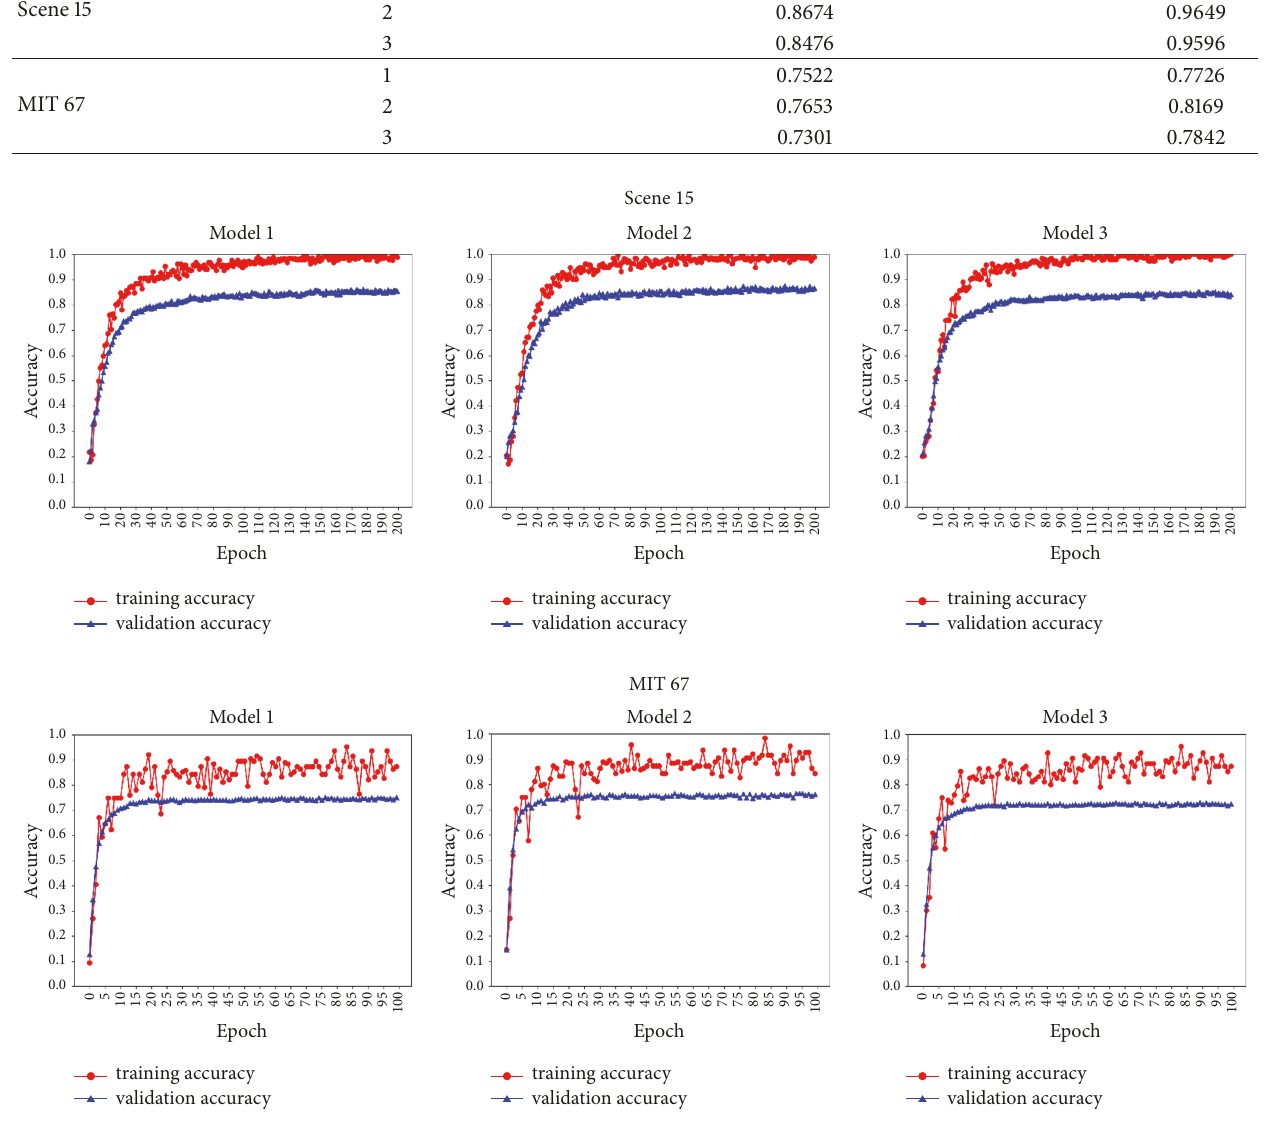
Figure 6: The training curves of fine-tuning CNNs on Scene 15 dataset and MIT 67 dataset with the pretrained